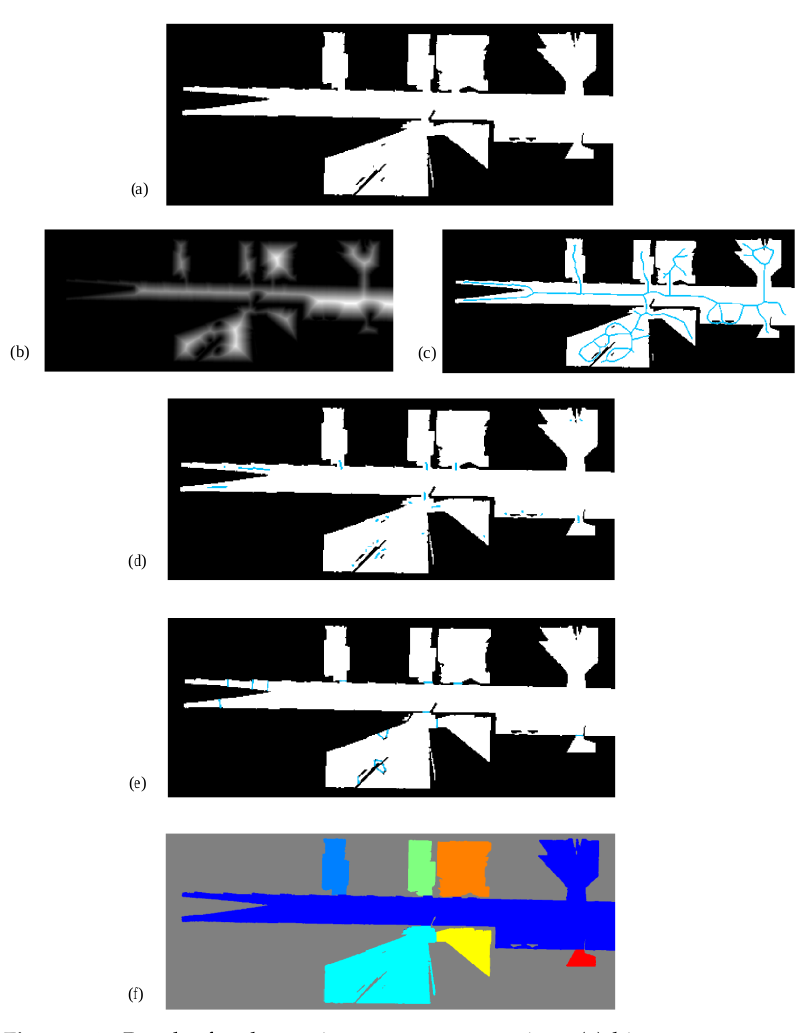
Figure 14. Results for the environment segmentation: ( a ) binary occupancy map, ( b ) distance transform of the free zones for the occupancy map, ( c ) skeleton marked in blue ( d ) line segments representing possible doors, ( e ) final geometric segmentation where areas smaller than 1.5 m 2 have been merged with their neighbors, ( f ) rooms and corridors segmented with different colors.